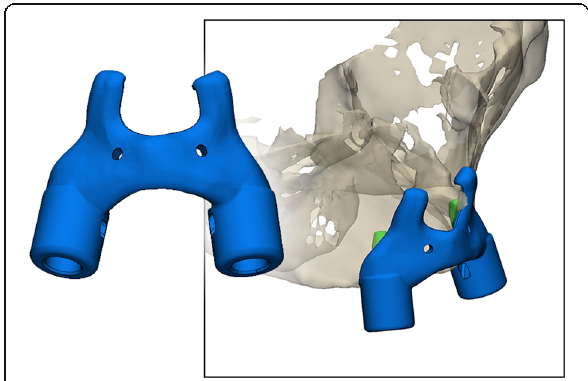
Fig. 2 Template design. Notice the brackets in the anterior nasal aperture forcing the template into position ensuring an exclusive fit. Also note the two holes that were added to be able to get a good retention of the template. In none of our patients, however, we had to insert screws to allow for the required stability of the template as the template was stable without the use of